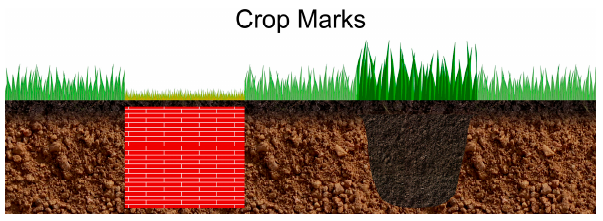
Figure 2. Crop marks: surface residues in the overlying vegetation of a buried wall ( left ) and a buried Figure 1. Soil marks: surface residues in bare soil of a buried wall ( left ) and a buried ditch ( right ). ditch ( right ).